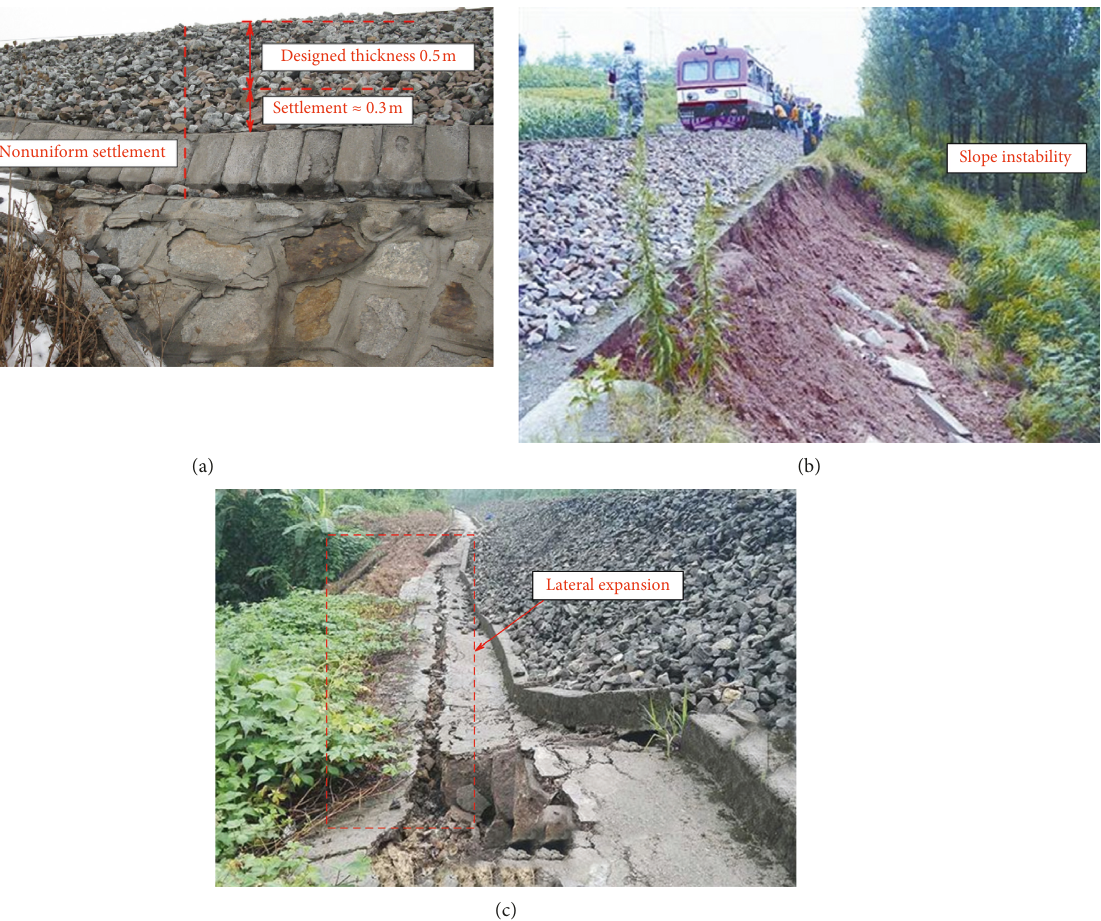
Figure 1: Embankment problems: (a) excessive subgrade settlement; (b) embankment slope instability; (c) lateral expansion of the embankment